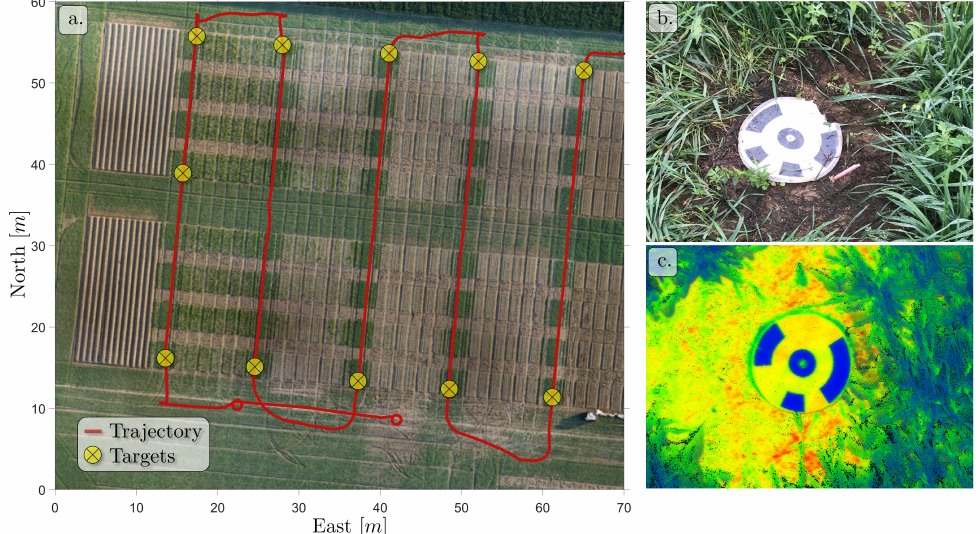
Figure 5. ( a ) Targets and trajectory of the kinematic laser scanning system in the experimental field; ( b ) image of an example target; ( c ) target in point cloud colorized by the laser intensity.